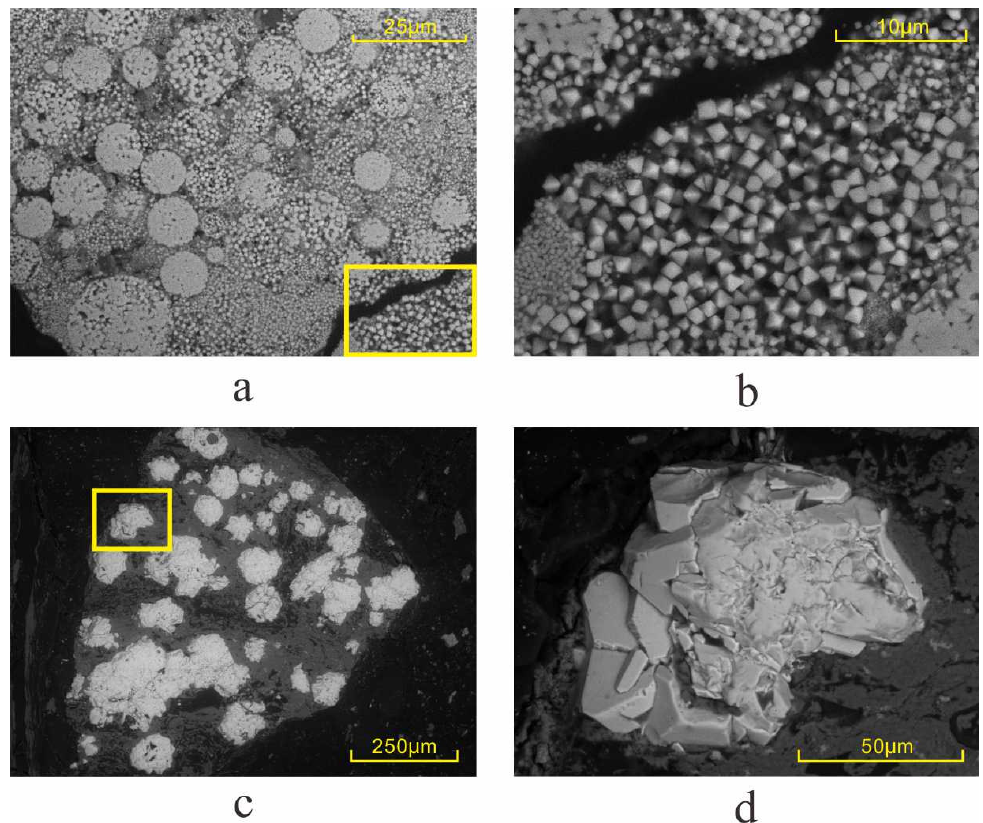
Figure 6. SEM back-scattered electron images of pyrite in the coals of Huainan coalfield. ( a ) Pyrite aggregates occurring as framboids, S10, GQ mine, No. 8 coal seam; ( b ) euhedral pyrite crystals surrounded framboidal pyrite, an enlarged image of the yellow rectangle in ( a ); ( c ) pyrite aggregates occurring as a massive form, S11, XZZ mine, No. 8 coal seam; ( d ) a pyritohedral pyrite crystal, an enlarged image of the yellow rectangle in ( c ).